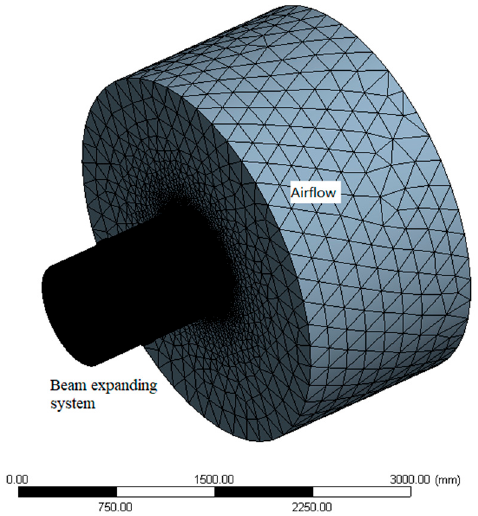
Figure 3. Simulation model of the beam expanding system.